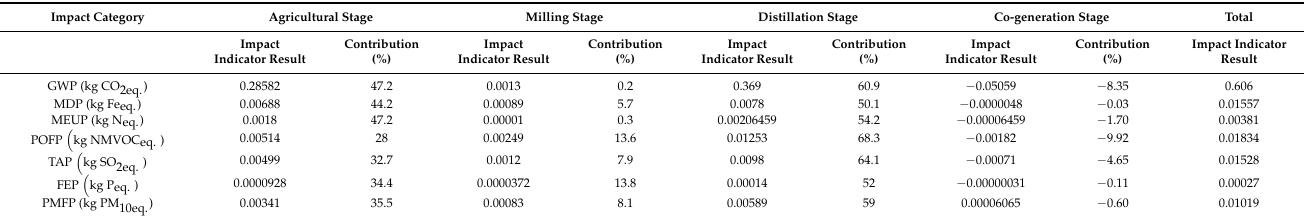
Table 5. Impact categories in different stages to produce ethanol (FU = 1 L of